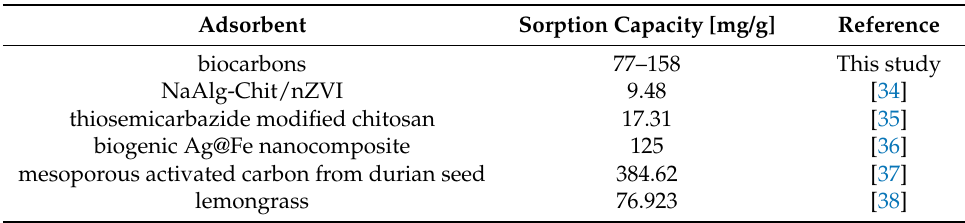
Figure 4. Langmuir ( a ) and Freundlich ( b ) isotherms onto biocarbons. Table 5 presents the values of the sorption capacities obtained for the biocarbons studied and the literature data for other adsorbents. According to Table 5 data, the bio- carbons obtained from the residue of the extraction of chaga fungi ( Inonotus obliquus ) are superior relative to the parameters obtained for NaAlg-Chit/nZVI [34] and thiosemicar- bazide modified chitosan [31]. The adsorbent NaAlg-Chit/nZVI [34] was obtained from iron nanoparticles and sodium alginate chitosan. Methyl red adsorption on this nanocom- posite [34] has shown that this process occurred according to the Langmuir model, and the value of q max for this adsorbent was 9.48 mg/g. Moreover, with regard to thiosemicarbazide modified chitosan, whose maximum sorption capacity toward methyl red was 17.31 mg/g, the adsorption occurred according to the Langmuir model [35]. A much greater sorption capacity has been reported for biogenic Ag@Fe nanocomposite [36], although it was lower than those of AFm, ACm and ACc obtained from the residue of the extraction of chaga fungi. According to Table 5, a much greater sorption capacity towards methyl (over twice greater than that of Acc) has been achieved by mesoporous activated carbon from durian seed [37]. The biocarbon adsorbent was obtained as a result of the chemical activation of durian seeds by KOH. The adsorption on this adsorbent was best fitted with the Freundlich model, so it had a multilayer character. Table 5. Comparison of sorption capacities (methyl red) of biocarbons with other adsorbents pre- sented in the